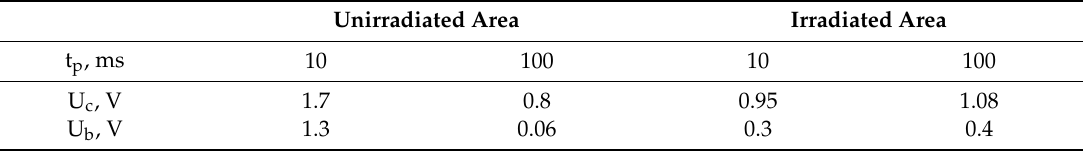
Figure 5. The local piezoelectric hysteresis loops measured in the closely spaced unirradiated ( a ) and irradiated ( b ) areas. The black and red loops correspond to the pulse duration t p = 10 and 100 ms, respectively. The inset shows the pulse train. Table 2. The values of U b and U c in the irradiated area of ZFC SBN.